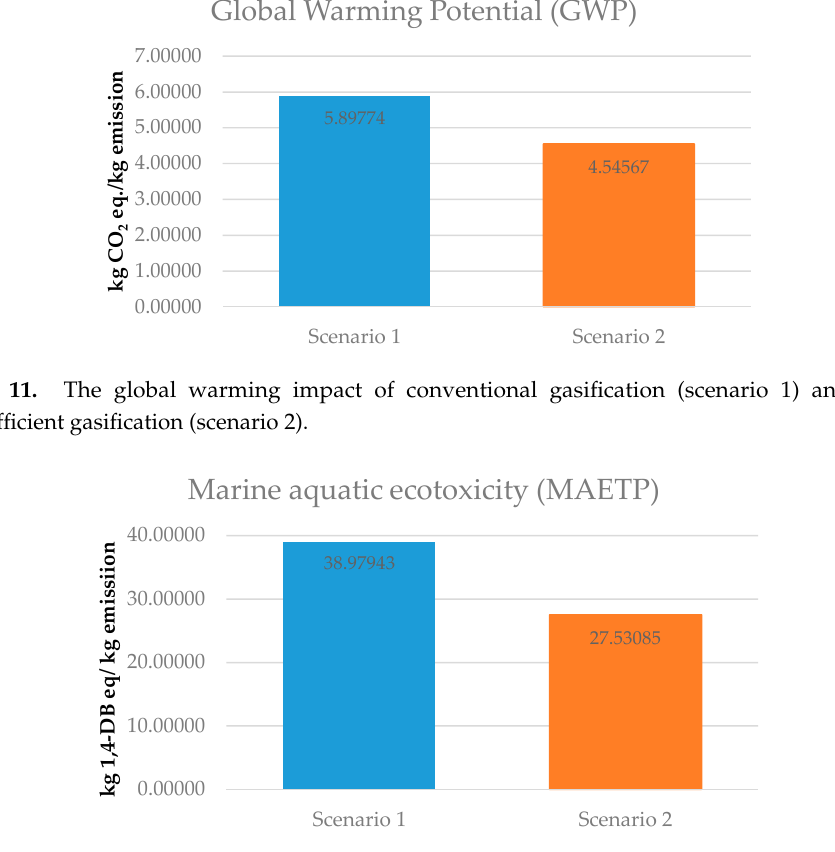
Figure 12. The marine aquatic ecotoxicity impact of conventional gasification (scenario 1) and energy self-sufficient gasification (scenario 2).